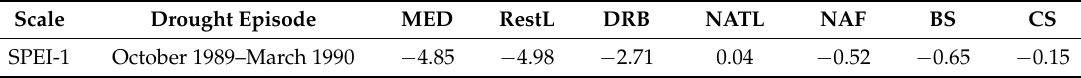
Table 3. Anomalies of the moisture supply from the sources over DRB accumulated during the drought episode that occurred on SPEI-1 associated with the event 1989/1990 (in mm/day).